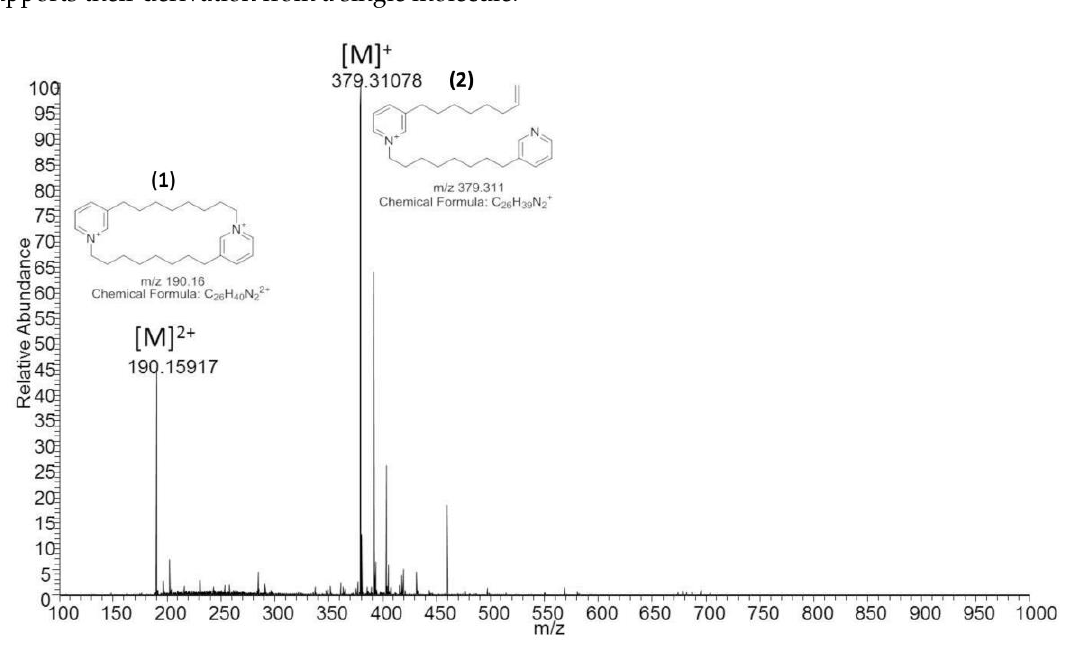
Figure 2. Major peaks observed during ESI(+)_MS of the active SPE fraction 2 from A. chloros . SPE fraction 2 of A. chloros shows an abundance of the linear [M − H] + m / z 379.31 species, referred to as compound 2 , as well as the cyclic [M] 2+ doubly charged species at m / z 190.16, referred to as compound 1 .